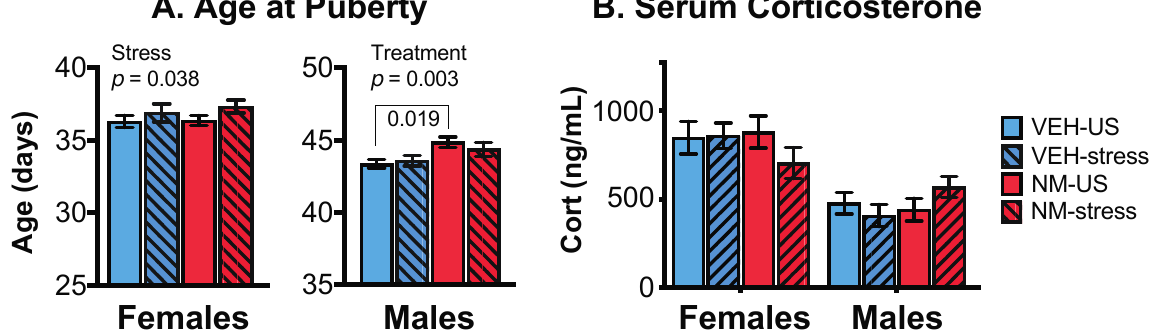
Figure 2. Effects of prenatal NeuroMix and/or stress in adolescence on the timing of puberty in female (A) and male (B) rats, and on serum corticosterone concentrations (C). ( A ) In females, the age at vaginal opening was significantly delayed by stress (striped bars). In males, treatment significantly delayed the timing of puberty, and there was also an interaction of treatment and stress as indicated by the brackets. Sample sizes for puberty are the same as in Figure 1. ( B ) Serum corticosterone concentrations were unaffected by treatment or adolescent stress. Sample sizes for serum corticosterone are n = 12 per group. Cort = corticosterone; VEH = Vehicle; NM = NeuroMix; US = unstressed.